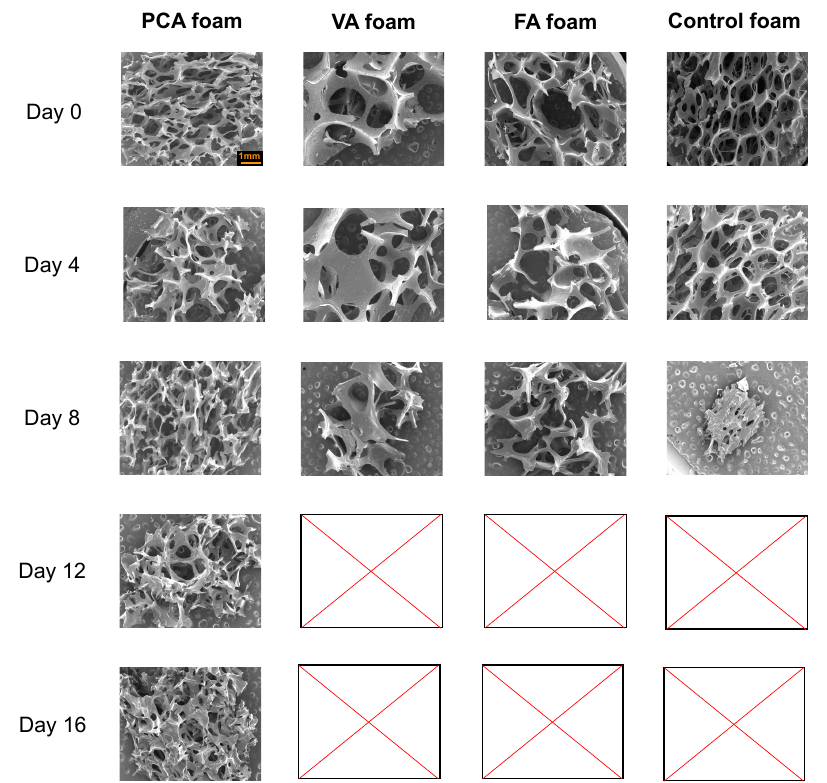
Figure 2. Scanning electron microscopic analysis of SMP foams over 16 days of degradation in in 20% H 2 O 2 . Blank pictures indicate that samples were completely degraded and could not be imaged. Scale bar applies to all images.